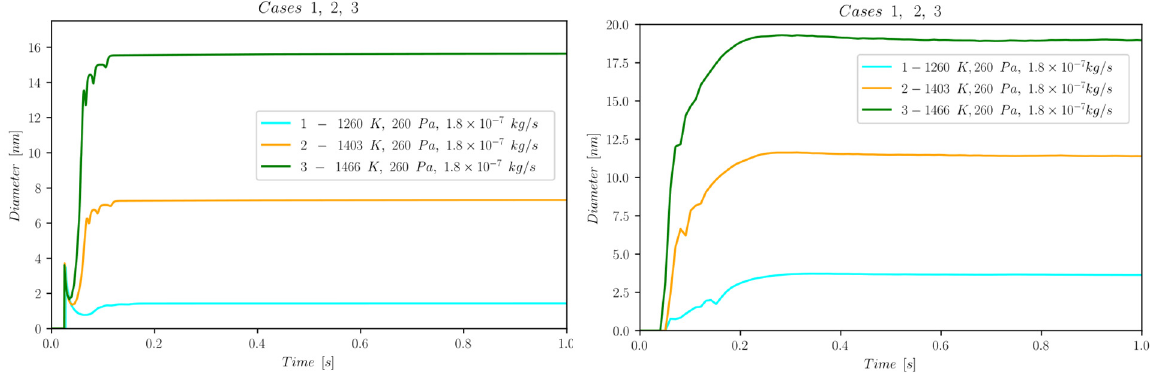
Figure 5. Temporal evolution of 𝑑̅ for cases 1, 2, and 3 belonging to subclass i (temperature depend- ence); ( left ) MoM, ( right ) PBM.